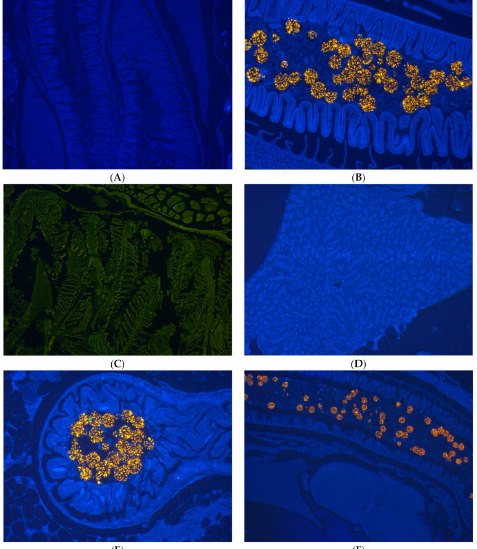
Figure 5. ( A ) Intestine of zebrafish, control. 40 × Magnification. ( B ) Polyethylene MPs in the intestine of adult zebrafish exposed to 50 mg.L − 1 for 96 h, 80 × magnification. ( C ) MPs were not observed in gills of zebrafish exposed to 50 mg.L − 1 , 40 × magnification. ( D ) Absence of polyethylene MPs in liver of zebrafish exposed 50 mg.L − 1 , 40 × magnification. ( E ) Lumen of intestine of zebrafish full of MPs after exposure to 50 mg.L − 1 for 96 h, 80 × magnification. ( F ) Presence of MPs in the intestine; MPs were not ob-served in the other organs. 60 ×